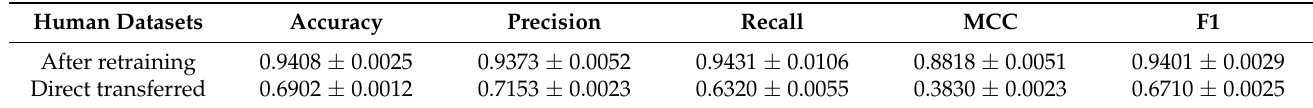
Table 10. Performance of CircPCBL on human dataset.